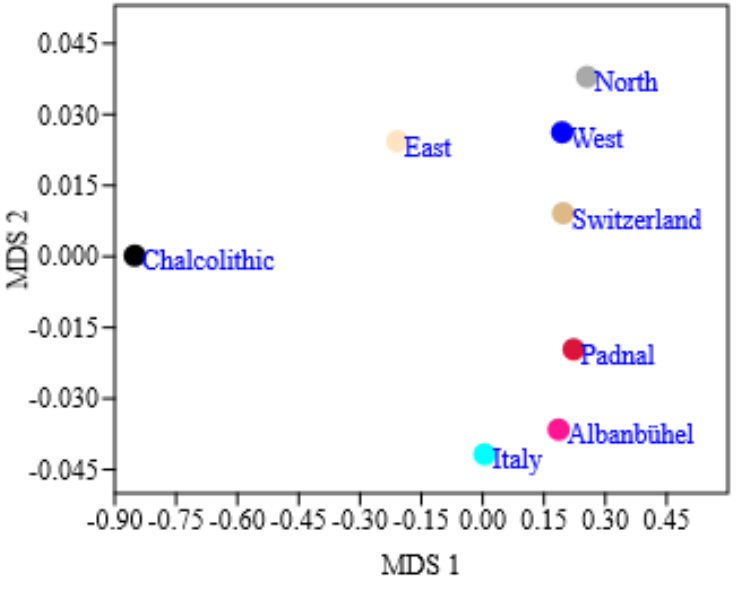
Figure 4. Non-metric MDS plot based on Reynolds genetic distances and 197 bp d-loop sequences from cattle breeds broadly grouped to different geographic regions (the geographic grouping of breeds is given in Table S2).